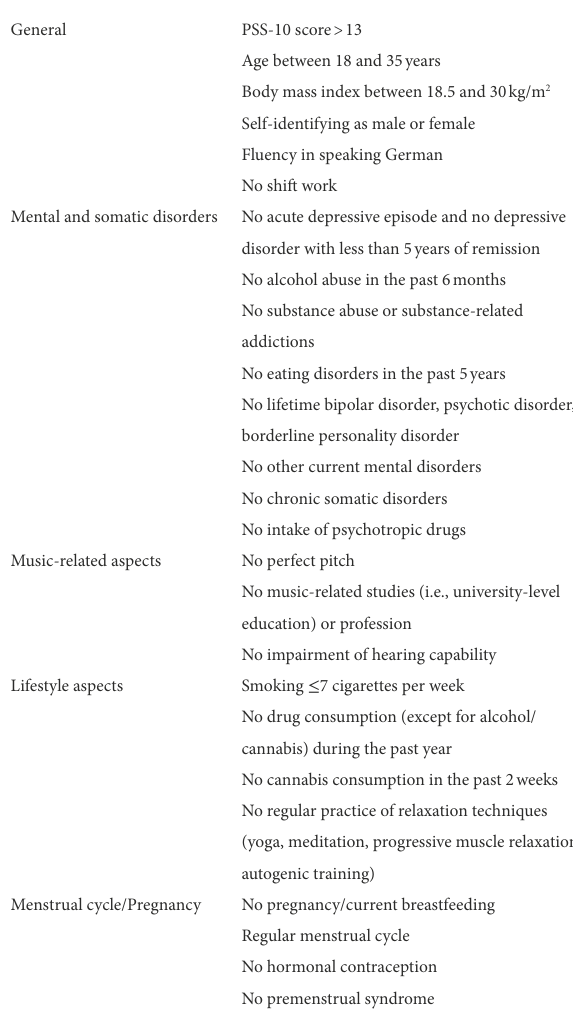
TABLE 1 Inclusion